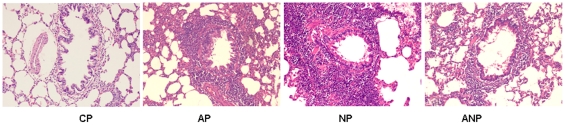
Histopathology examination of lung in each maternal group.No obvious lesions of airway structure were appeared in CP rats.
Bronchial epithelial shedding, eosinophil and neutrophils infiltration
surrounding airway were found in AP rats, and these pathological changes
were aggravated in NP rats and alleviated in ANP rats. (The
magnification of the image is 100 ×).